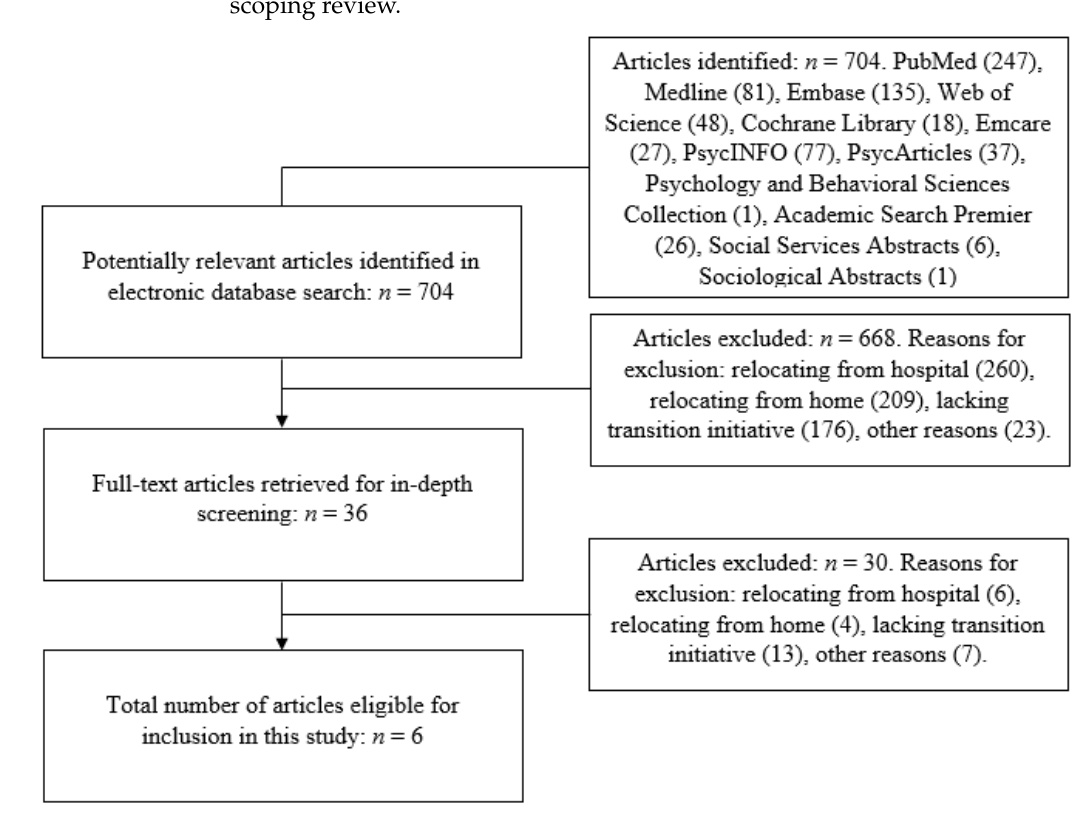
Figure 2. Flow Figure 2. Flow diagram.